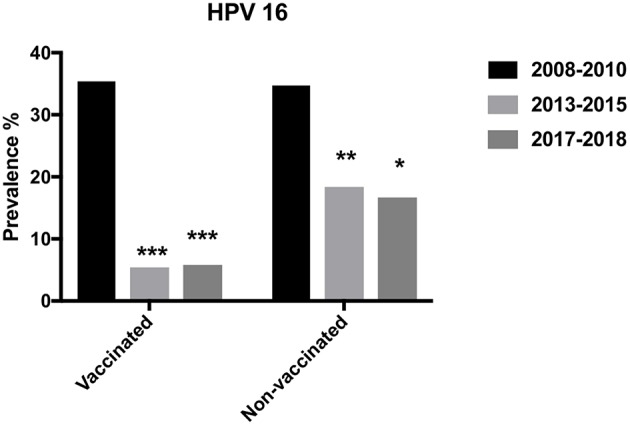
Prevalence of HPV16 in vaccinated and non-vaccinated women over the years 2008–2010, 2013–2015, and 2017–2018. *p < 0.05, **p < 0.01, ***p < 0.001.